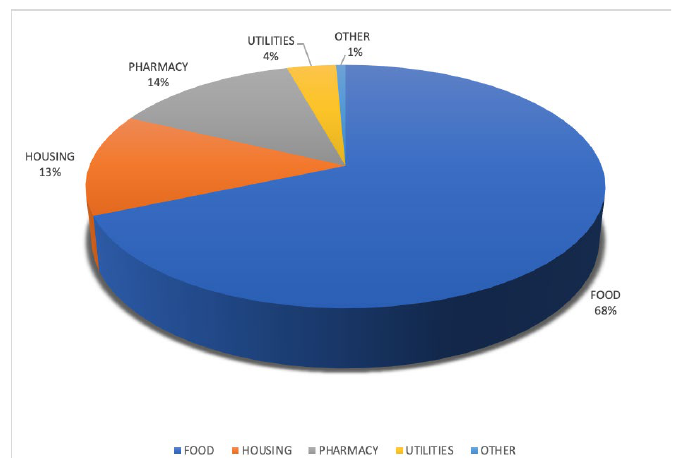
Figure 2. Categorization of social support